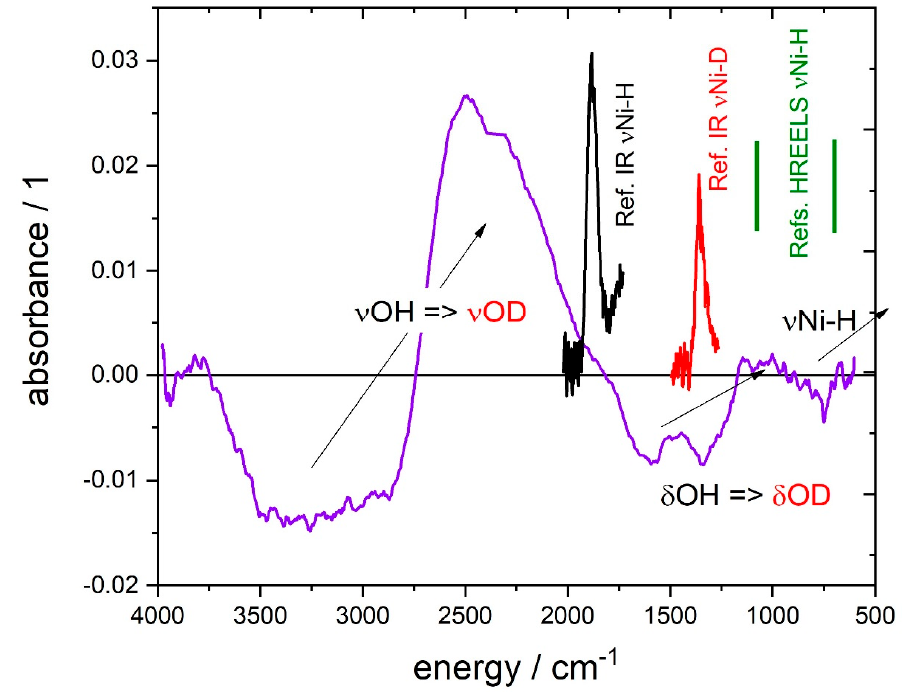
Figure 4. DRIFTS deuterium di ff erence spectrum of Ni on alumina / silica (catalyst exposed to deuterium at room temperature minus background taken after reduction in hydrogen). Reference data on H vibrations on Ni: [12] (IR); high-resolution reflecting electron energy loss spectroscopy (HREELS): 1120 cm − 1 ; 704 cm − 1 [49]; 1035 cm − 1 ; 630 cm − 1